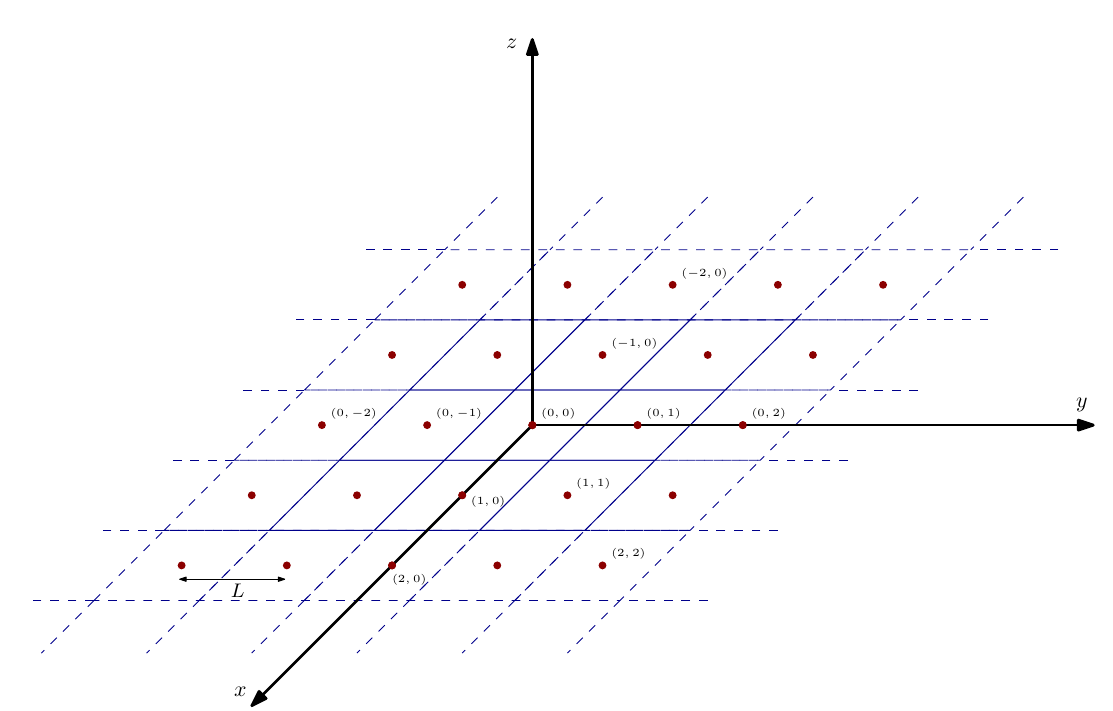
Figure 6 . Each square of size L × L represents a torus T 2 in the compactified x, y dimensions, with a monopole at the center. Due to periodic boundary conditions, the torus is replicated to form a two dimensional infinite array with monopoles located at ( m, n ) L ∈ Z × Z . The field of the array of monopoles within small T 2 × R is the one of a quantum mechanical